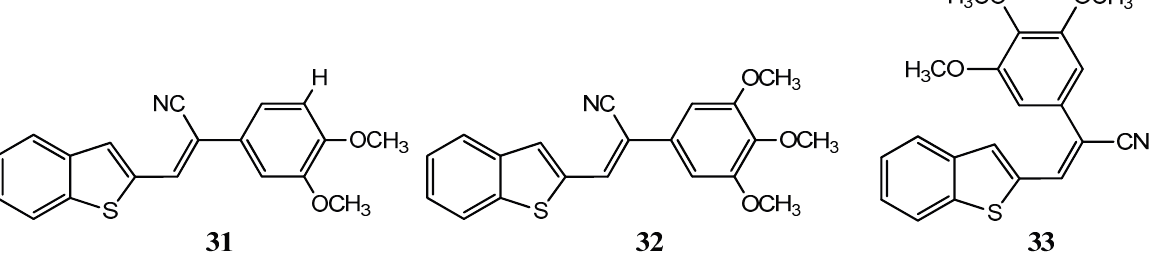
Figure 17. Chemical structure representation of synthetized benzothiophene acrylonitrile derivatives, ([ Z -3-(benzo[ b ]thiophen-2-yl)-2-(3,4-dimethoxyphenyl)acrylonitrile] ( 31 ), [ Z -3- (benzo[ b ]thiophen-2-yl)-2-(3,4,5-trimethoxyphenyl)acrylonitrile] ( 32 ) and [ E -3-(benzo[ b ] thiophen-2-yl)-2-(3,4,5-trimethoxyphenyl)acrylonitrile]) ( 33 ) with promising antiproliferative activity